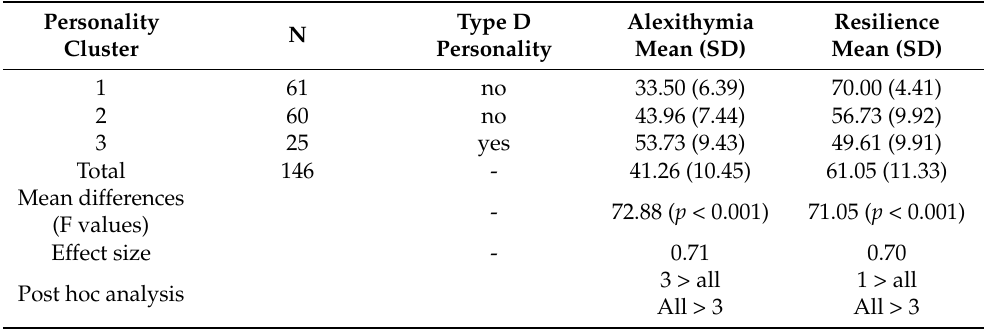
Table 2. Means, standard deviations and differences between means in the assessed variables for each cluster